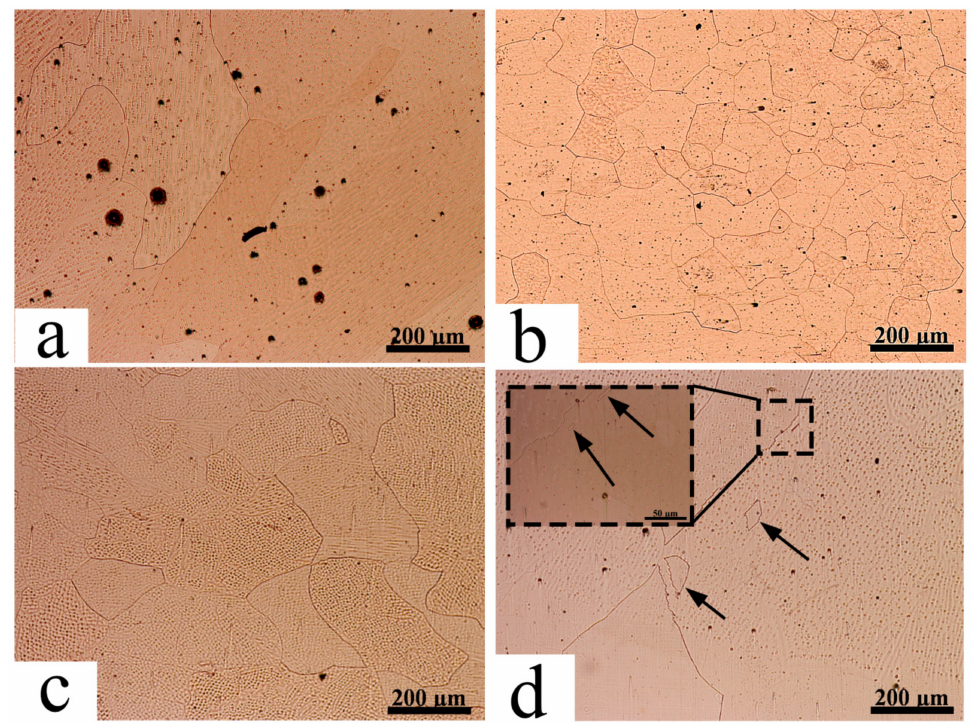
Figure 4. The evolution of the microstructure and porosity distribution in the nugget zone of GTA spot-welded copper joints welded without USV ( a ) and (with USV) for ( b ) 2 s; ( c ) 4 s; and ( d ) 6 s.